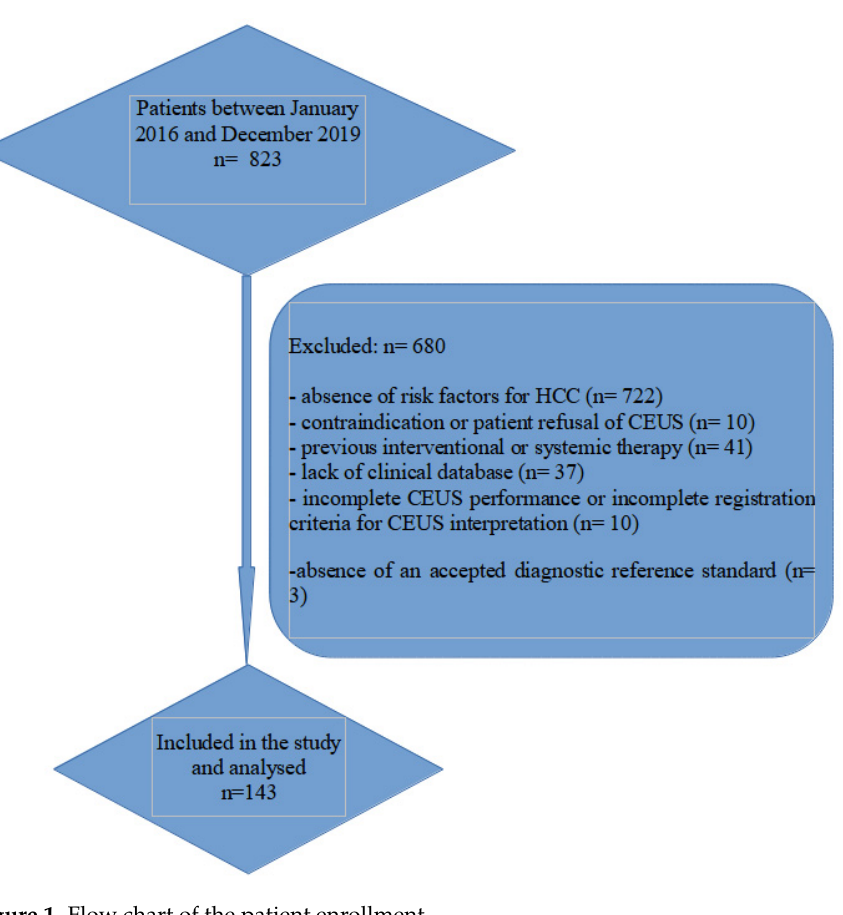
Figure 1. Flow chart of the patient enrollment.